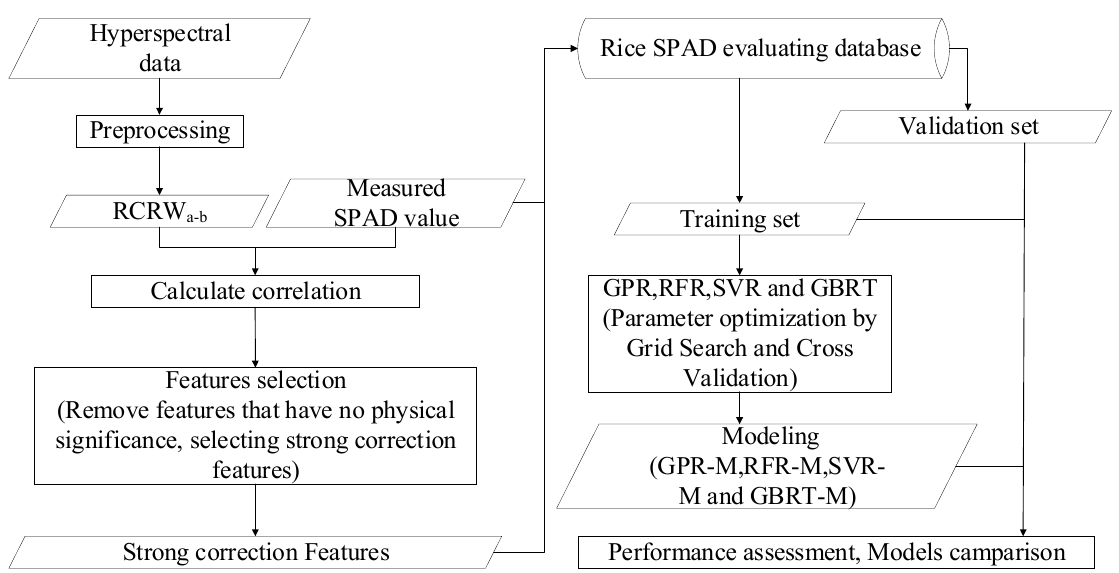
Figure 3. Proposed workflow for this study.